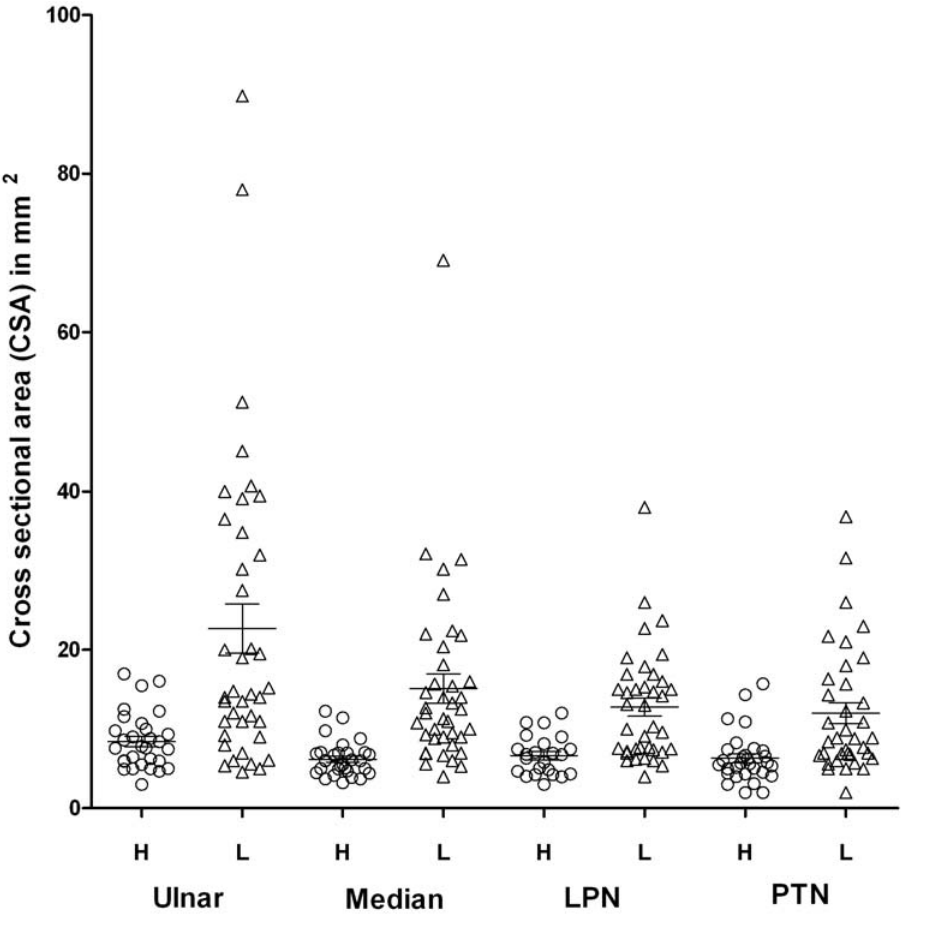
Figure 2. Comparison of mean cross-sectional areas (CSA in mm 2 ) in nerves from leprosy patients as compared to healthy control subjects. The mean CSA in mm 2 6 SD as determined by ultrasonography from 20 leprosy patients (L, open triangle) showed highly significant increase (p , 0.0001, Mann Whitney) as compared to 30 healthy control subjects (H, open circle) for ulnar, median, lateral popliteal (LPN) and posterior tibial nerves (PTN). There was a wider scatter in the diseased nerves as compared to healthy controls. Fig. 3 and Video S1 show an example of increased flow in the UN (Fig. 3B) in comparison to UN without flow (Fig. 3A) and Fig. 3C shows no flow in MN in spite of a persisting artery. Of the 39 nerves with increased flow, 26 were from 12 patients with type 1 reaction and 13 were from the 4 patients with a type 2 reaction.